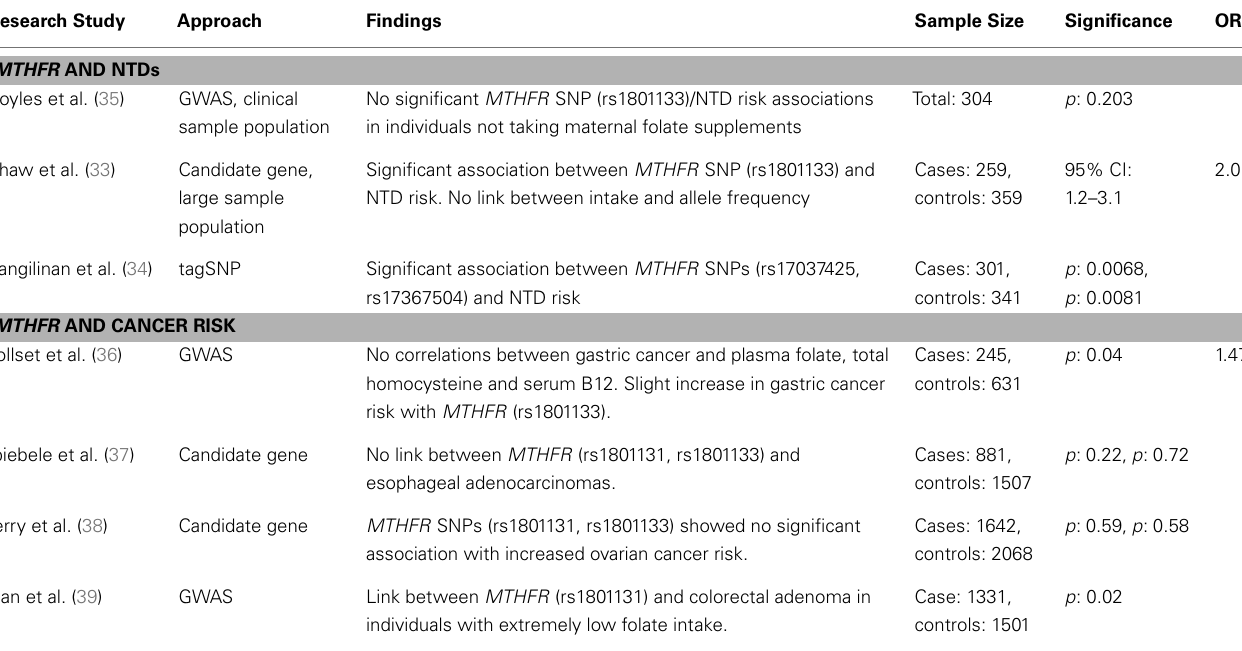
Table 2 | Major findings from association studies between MTHFR gene variants and two proof of principle diseases, neural tube defects, and cancer risk, including sample size, significance (as p or 95% confidence interval), and odds ratio (OR)